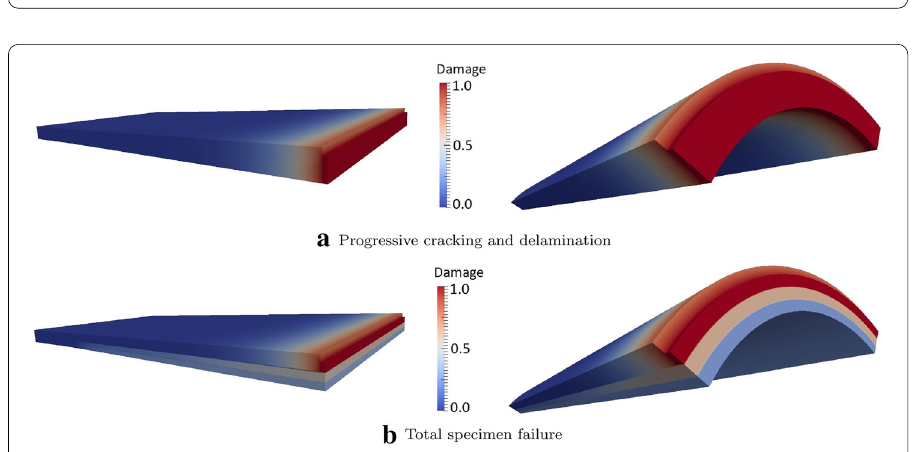
Fig. 14 Geometry of the 4-point-bending specimen in a and geometry of the cylinder under tension in b . Composite composition through the thickness in c (from [47])